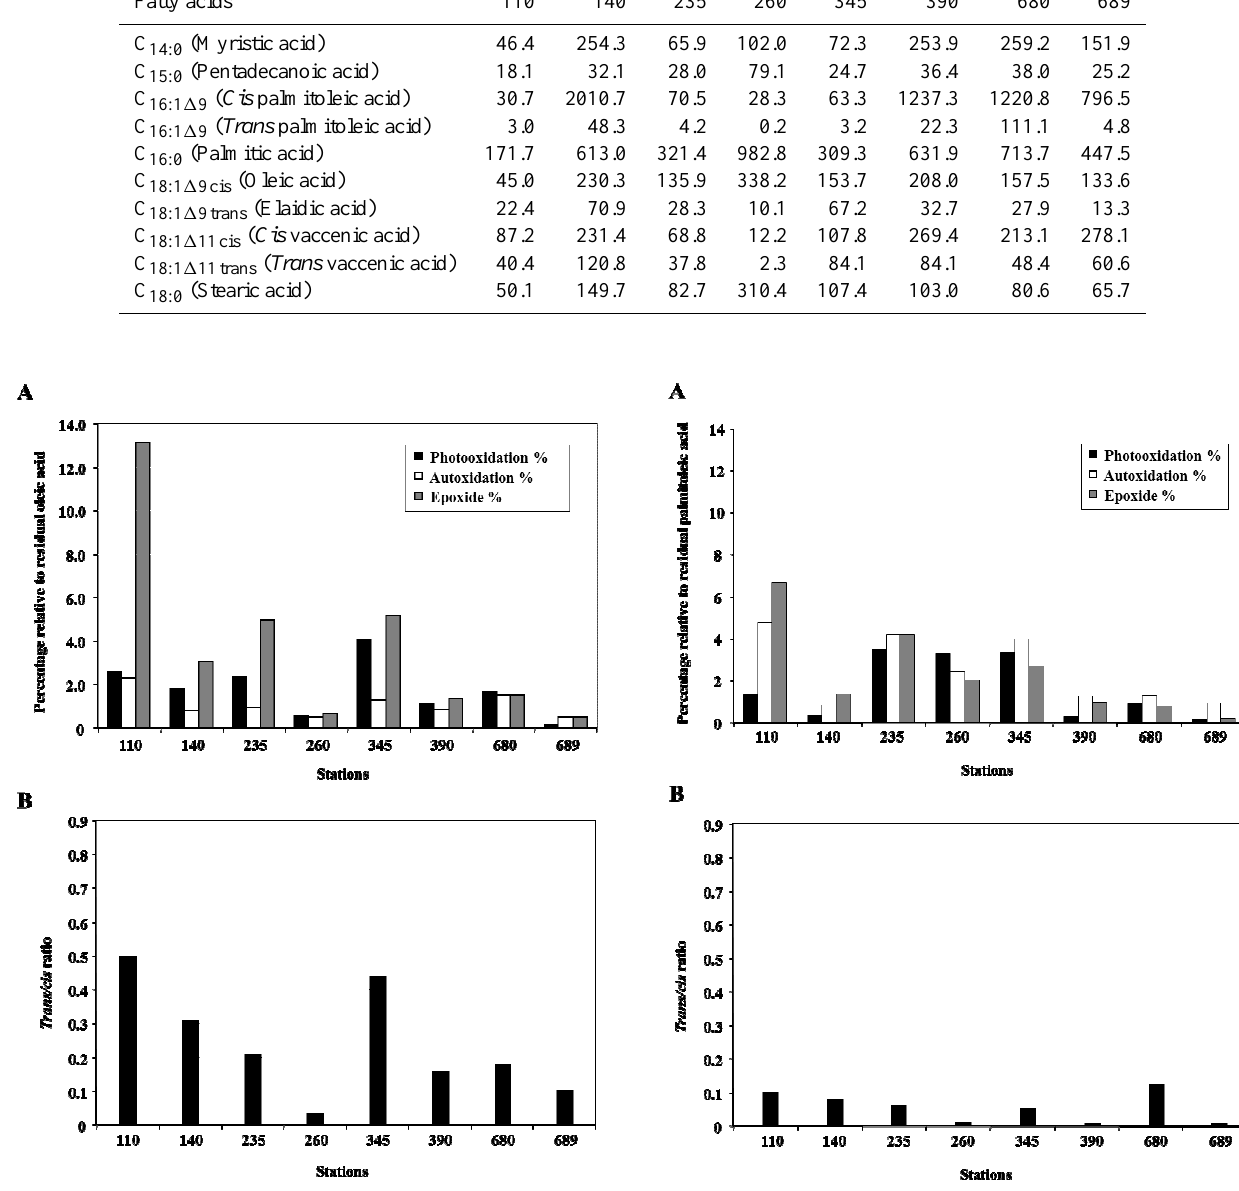
Fig. 6. Estimates of relative autoxidation, photooxidation and epox- ide production (as percentages relative to the residual parent com- pound) (A) and trans / cis ratio measured (B) of oleic acid for the different sediments investigated.